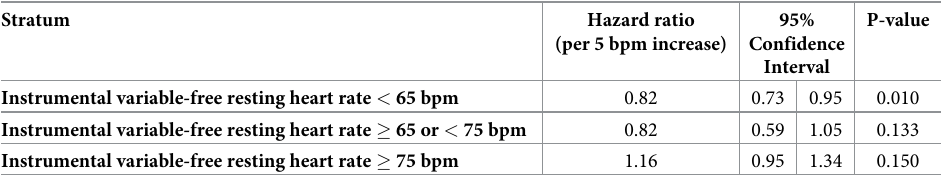
Table 2. Causal inference using instrumental variable